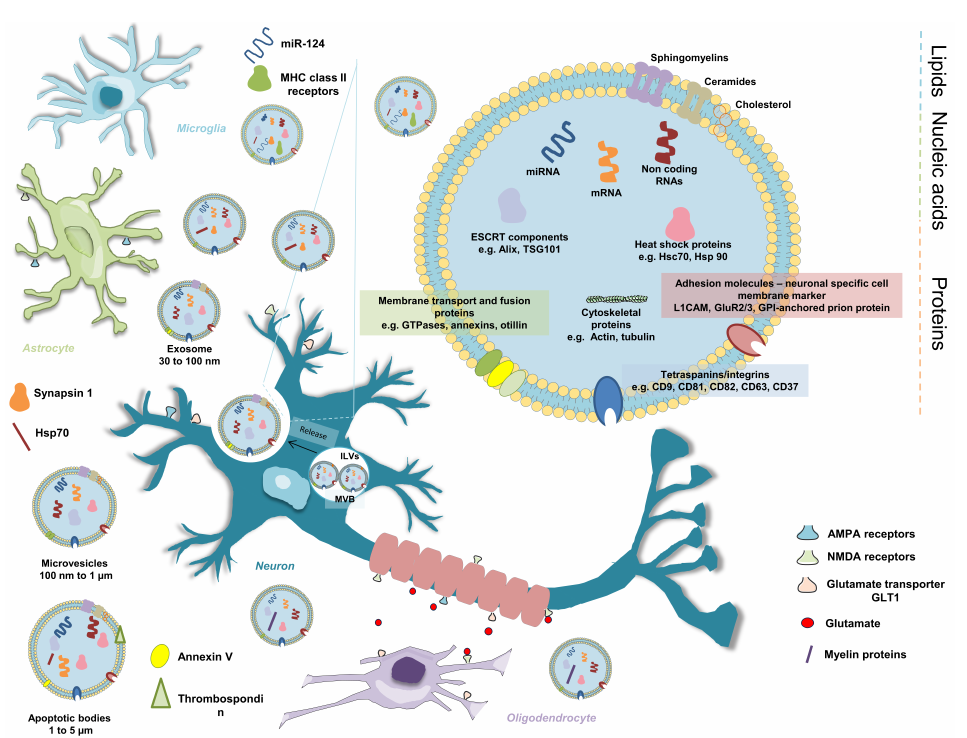
Figure 1. Schematic illustration of extracellular vesicles (EVs) in cell–cell communication in the CNS. EVs mediate intercellular communication between neurons, oligodendrocytes, astrocytes and glial cells. The EV is composed of lipids, proteins and polynucleotides. The cellular origin of EVs will define the cargo content and signaling capacity. For example, neural-derived exosomes carry synaptic cell adhesion molecules: neuronal-specific cell membrane marker L1CAM, GPI-anchored prion protein and GluR2 / 3. Proteins involved in vesicular tra ffi cking, such as Rab proteins, annexins and cytoskeletal proteins, are present in EVs derived from neuronal and non-neuronal